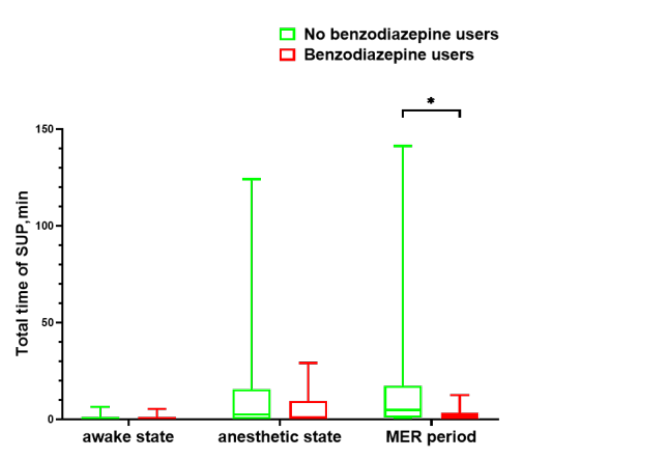
Figure 2. Box chart showing the suppression between the two groups during MER. For suppression during MER, there were significant differences between no benzodiazepine and benzodiazepine users regarding the total time of suppression and maximum suppression ratio. Significant changes are highlighted by * ( p < 0.05). MER: microelectrode recording, SUP: suppression.